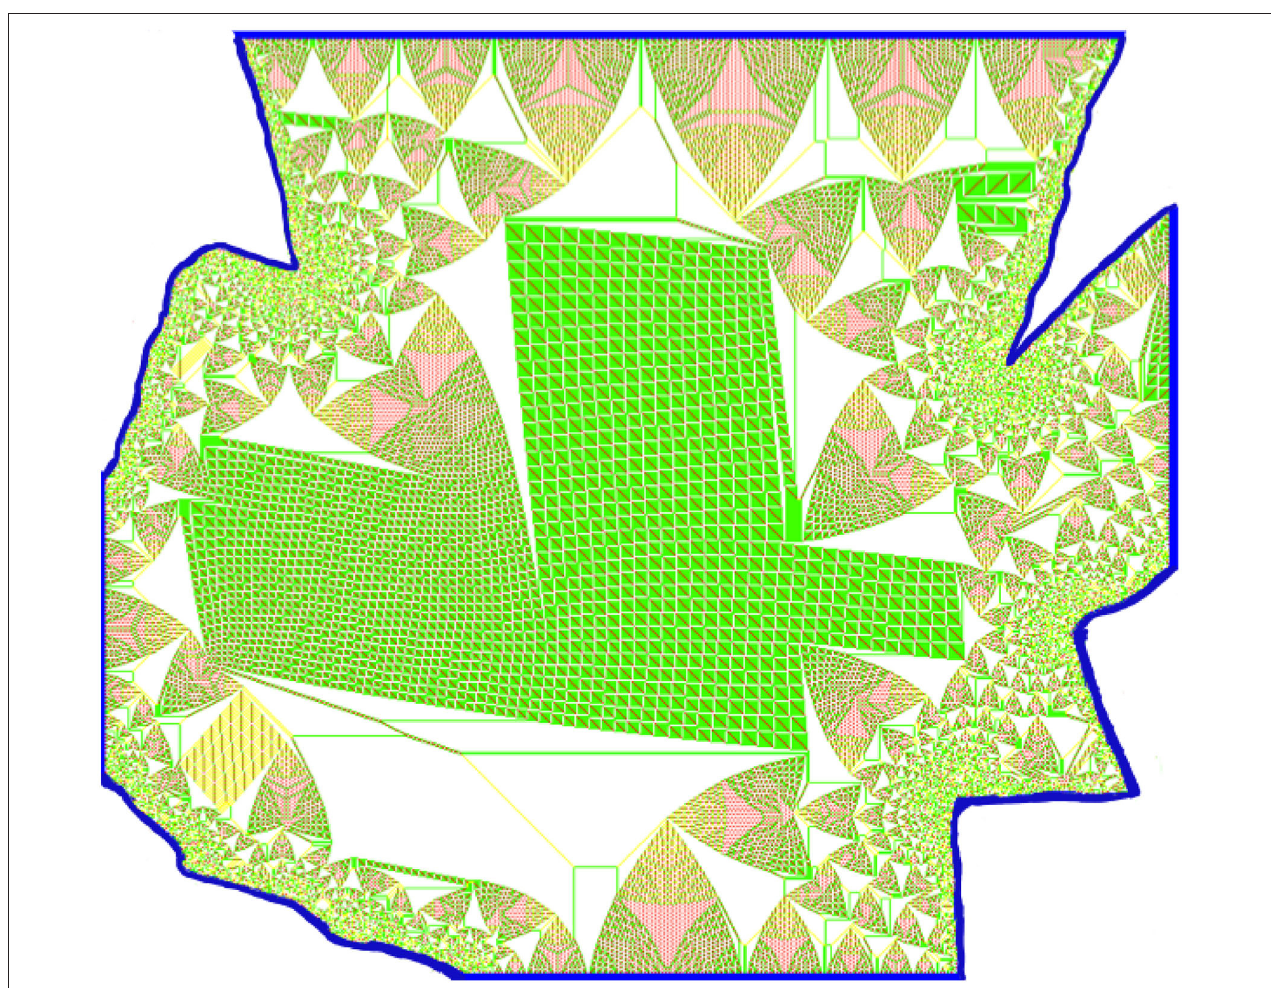
FIGURE 4 | The blue points mark the sinks. The identity of the remaining part of the lattice is presented. Note the presence of the linear patterns, the same as in the previous pictures. Colors are the same as in Figure 1